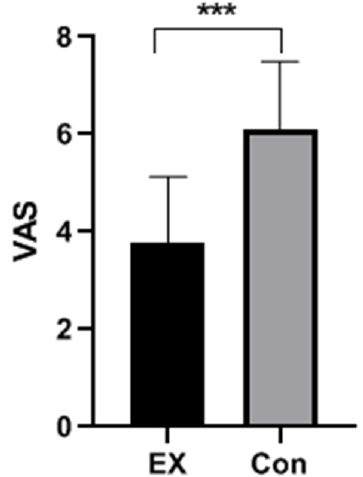
Figure 1. The score of VAS on evaluating subjects’ craving degree for mobile phones. Note: Ex: the exercise group; Con: the control group; VAS: visual analog scale. *** p < 0.001.